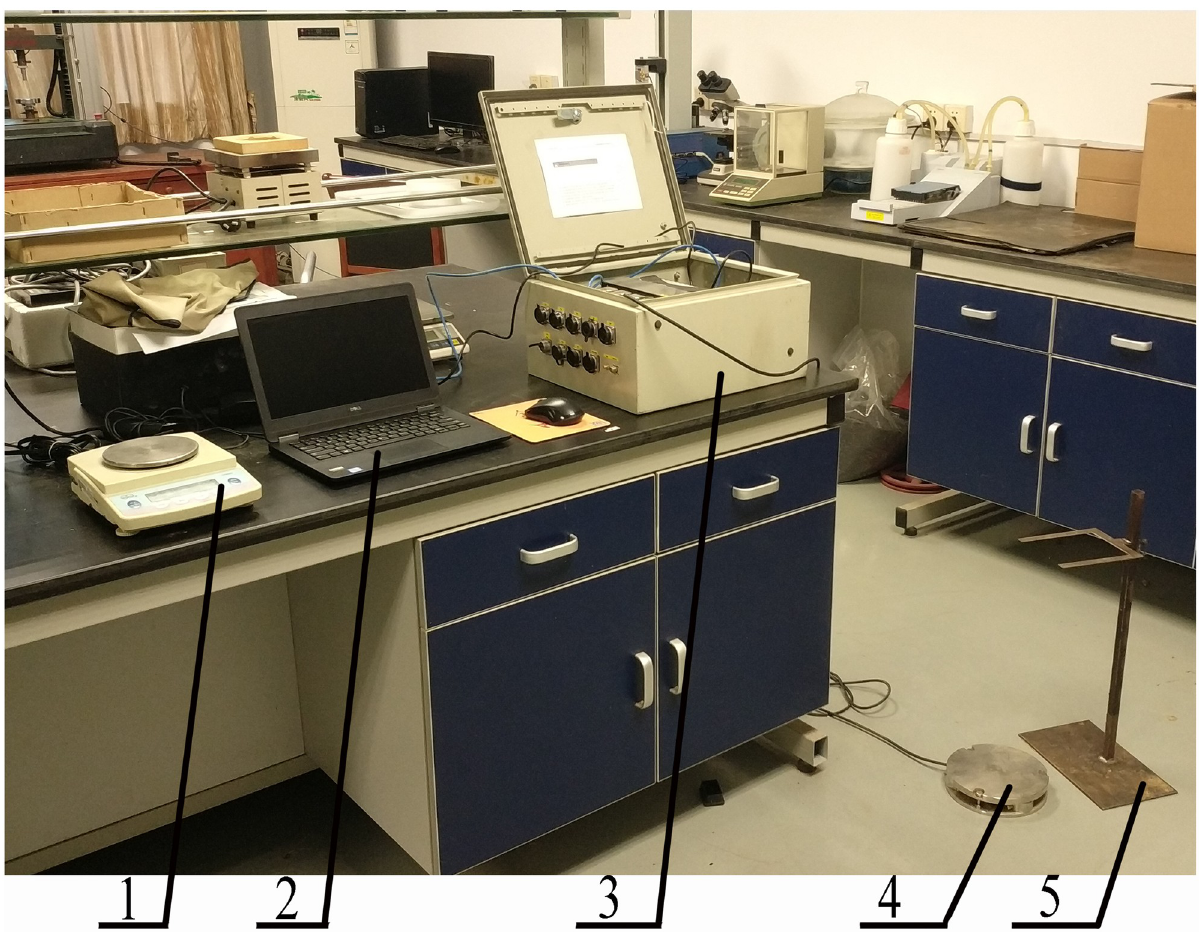
Fig 2. Sweet potato drop impact test system. 1. Electronic balance 2. Laptop 3. Signal amplifier 4. impact force sensor platform 5. Ruler frame.